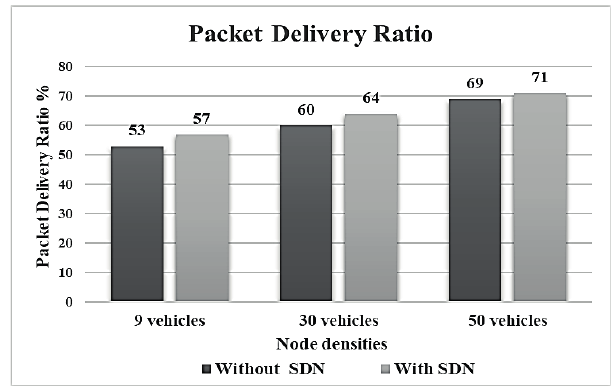
Fig. 10. Packet delivery ratio results (%).